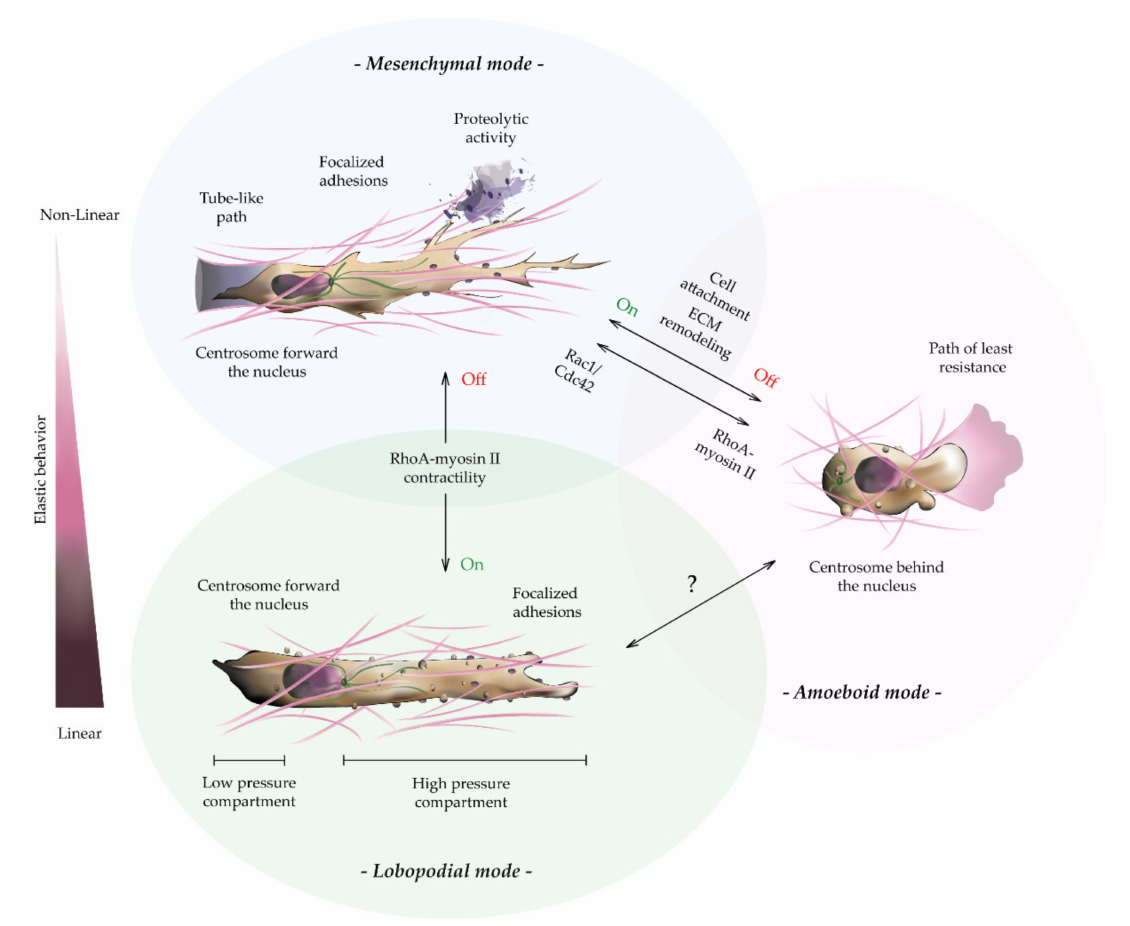
Figure 4. The elastic properties of the ECM and the crosstalk between the small GTPases govern cell migration plasticity within 3D environments. Three modes of 3D cell migration have been described in mammalian tissues, which can be uniquely classified based on the degree of ECM remodeling, cell-matrix attachment, and the modulation of the small GTPases signaling. Mesenchymal-based migration predominates in 3D environments with non-linear elastic behavior. Under these conditions, the polarized signaling of Rac1 and Cdc42 drives the formation of a fan-shaped protrusion at the leading edge by actin polymerization in combination with robust integrin-dependent adhesions. Likewise, Cdc42 signaling locates the centrosome in front of the nucleus facilitating cell axis polarization and directed cell migration. Actomyosin contractility acts throughout the cell body, where it strengthens focal adhesions and increases tensile forces without increasing intracellular pressure, as seen in amoeboid or lobopodial modes. Moreover, mesenchymal locomotion is often accompanied by the degradation of the pericellular area through the secretion of proteolytic enzymes, such as MMPs. ECM remodeling often generates tube-like paths used for collective cancer cell dissemination through dense and poorly organized matrices. On the contrary, lobopodial cells extensively use the actomyosin contractility, focused forward of the nucleus, to migrate in high-confined matrices with a linear elastic behavior. RhoA-myosin II signaling governs intracellular pressure, where the nucleus physically separates the cell body into two compartments. This asymmetrical hydrostatic pressure increases membrane tension at the leading edge, causing numerous, small spherical protrusions along their lateral surface. Despite this, both migration strategies involve elongated shape morphology, strong cell adhesions, and centrosome polarization. Amoeboid-like cell migration is characterized by low-adhesion and matrix remodeling-independent motility. Increased RhoA signaling causes a rapid retrograde flow of myosin II into the leading bleb that allows amoeboid cells to squeeze towards paths of least resistance. Of note, during cancer cell migration, tumor cells often undergo a mesenchymal-amoeboid transition as a consequence of the internal modulation of small GTPAses activity or the external ECM properties. Thus, elongated cancer cells can spontaneously switch into rounded-like amoeboid motility by depletion of MMPs or integrin activity, as well as by migrating through poorly adhesive substrates or upon the modulation of the Rho GTPases signaling. However, there are no clear insights underlying the transition between the lobopoidal and amoeboid mode, thus requiring further experimental